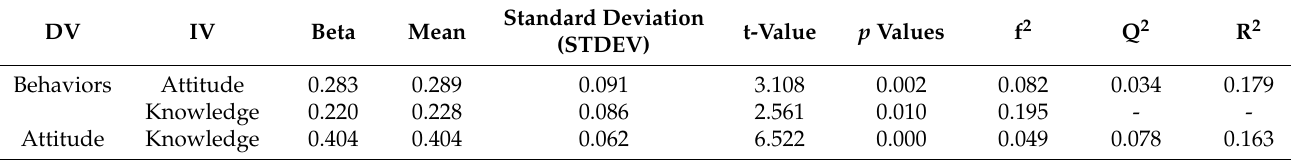
Table 6. Path coefficients of the model.